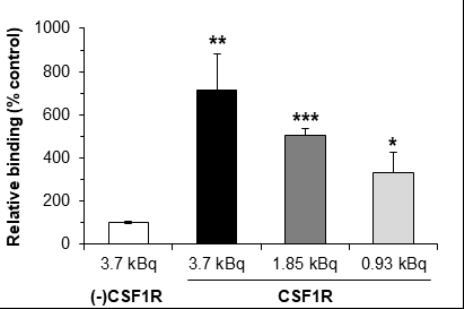
Figure 2. In vitro binding of [ 18 F] 1 to CSF1R. Binding levels are expressed relative to a value of 100 % for control (without CSF1R). Data represent mean ± S.D. (n = 3). * p < 0.05, ** p < 0.01, *** p < 0.001.